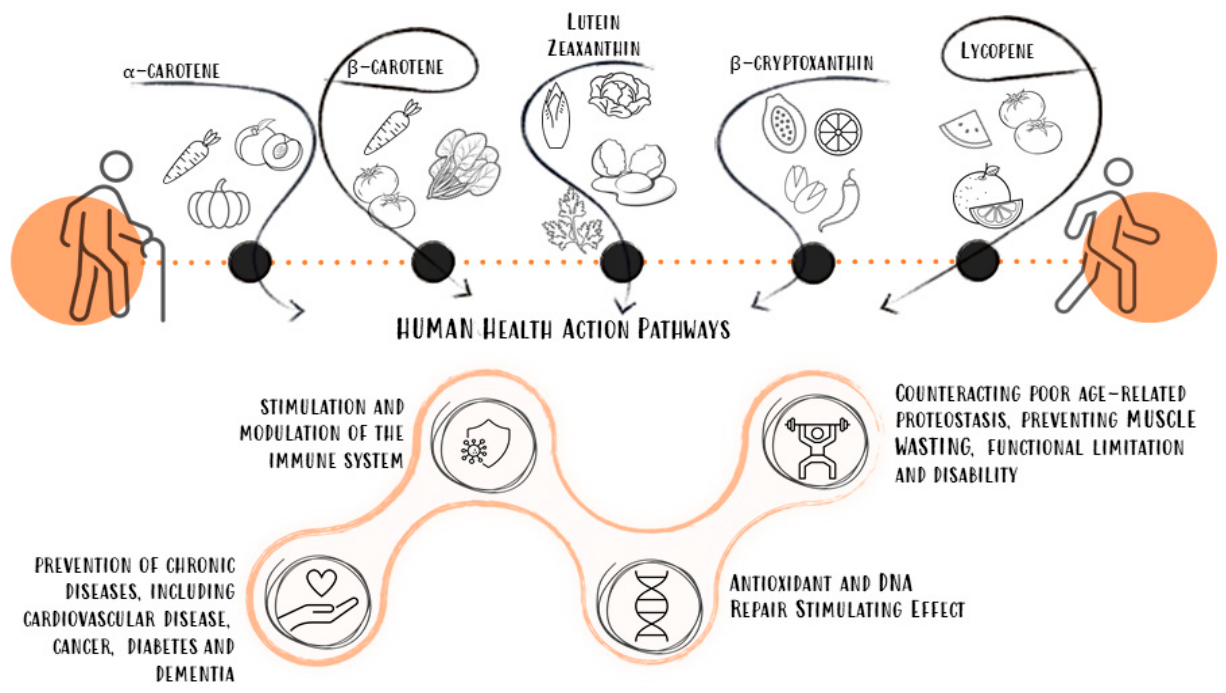
Figure 2. Graphic overview of the findings.